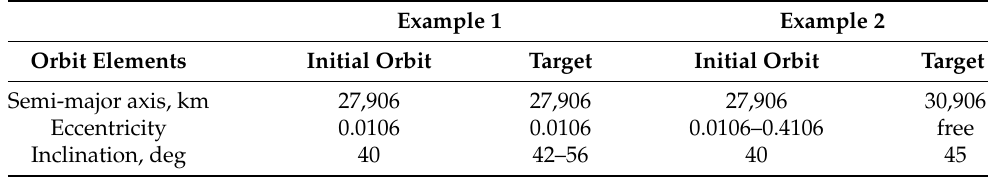
Table 5. Orbit elements of the initial orbit and the